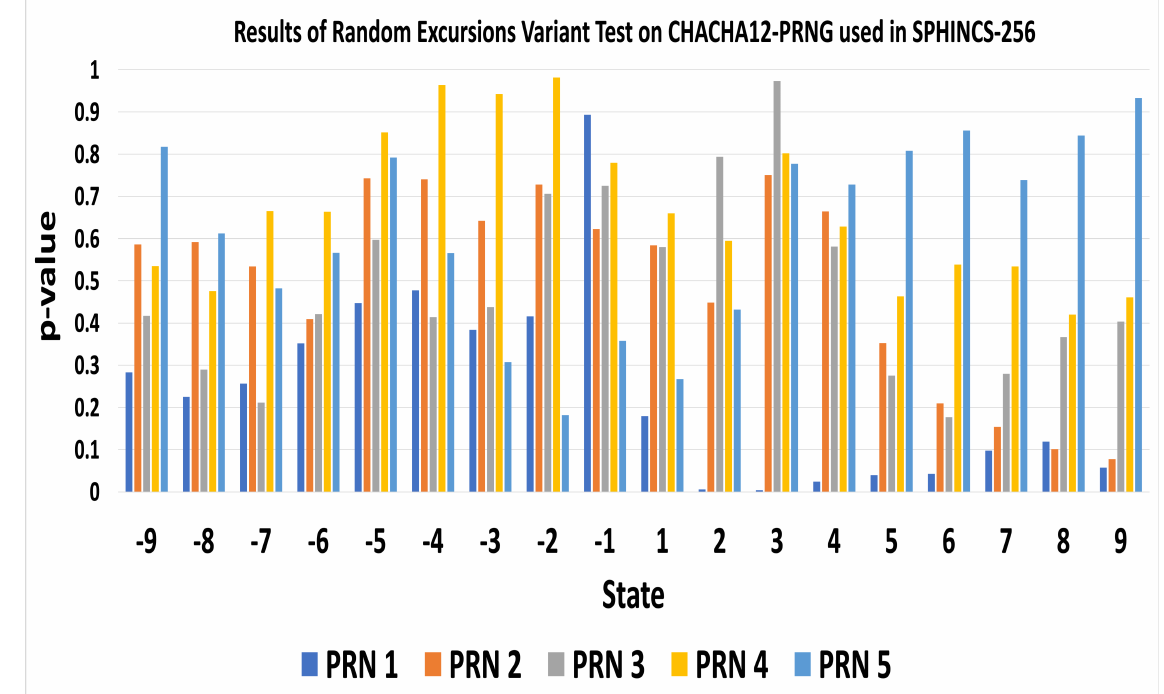
Figure 20. Results of Random Excursions Variant Test on Chacha-12 PRNG used in SPHINCS-256.